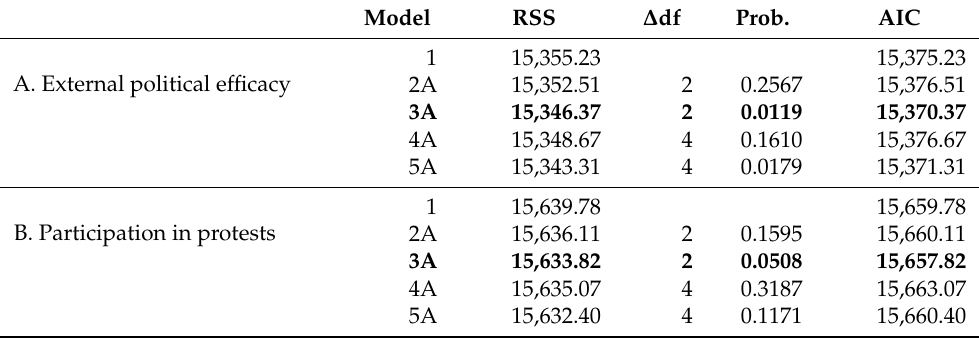
Table 3. Heterogeneous effects models (variations by age). Goodness-of-fit